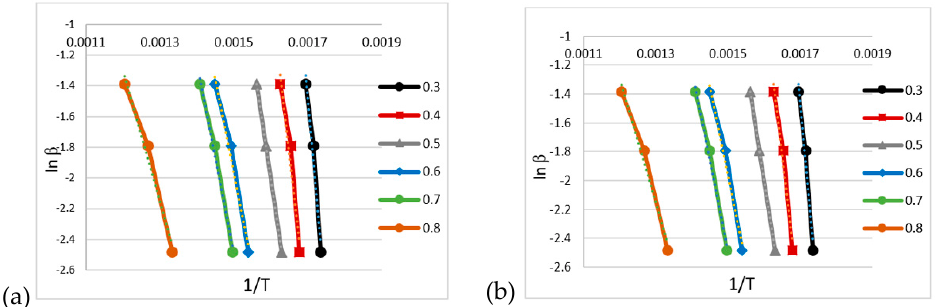
Figure 3. Plots for activation energy for determination for LEA ( a ) FWO model ( b ) KAS model. The best prediction of activation energy was at 0.3 < α < 0.8. α ; values below 0.3 pre-